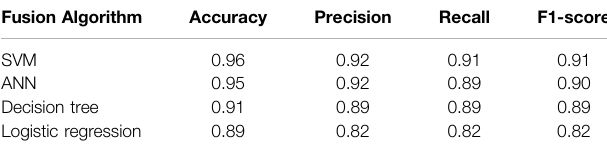
TABLE 2 | Comparison of fusion algorithm performance for corrosion detection. Fusion